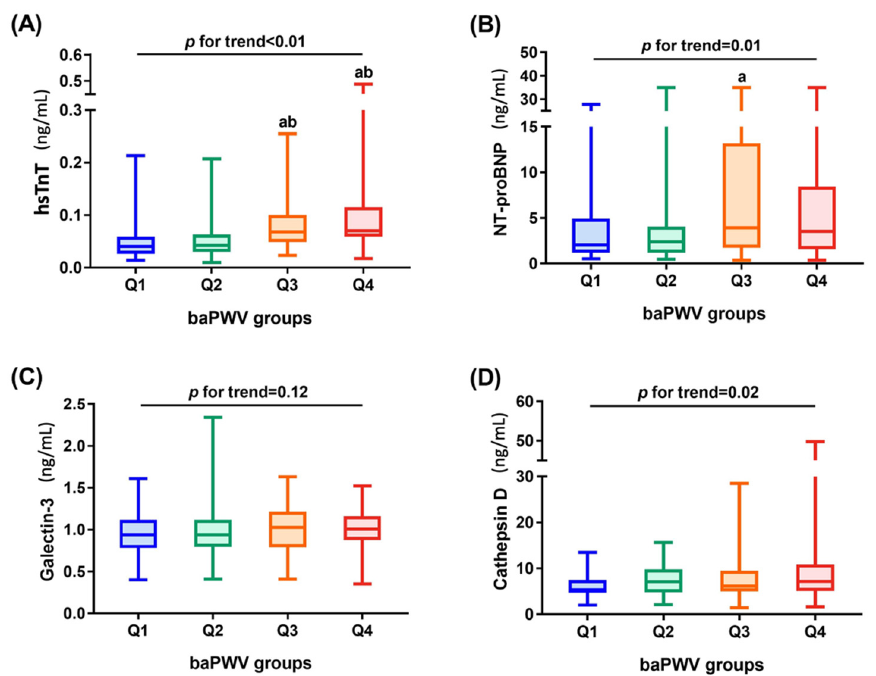
Figure 3. The mean values of CV biomarkers in quartile groups of brachial–ankle pulse wave velocity among hemodialysis patients: ( A ) high-sensitivity troponin T ( p for trend < 0.01); ( B ) N-terminal pro-brain natriuretic peptide ( p for trend 0.01); ( C ) Galectin 3 ( p for trend = 0.12); ( D ) Cathepsin D ( p for trend = 0.02). Multiple comparisons were performed by Dunn’s multiple comparison test (a. significant difference from Q1; b. significant difference from Q2). Statistical significance was defined as p <